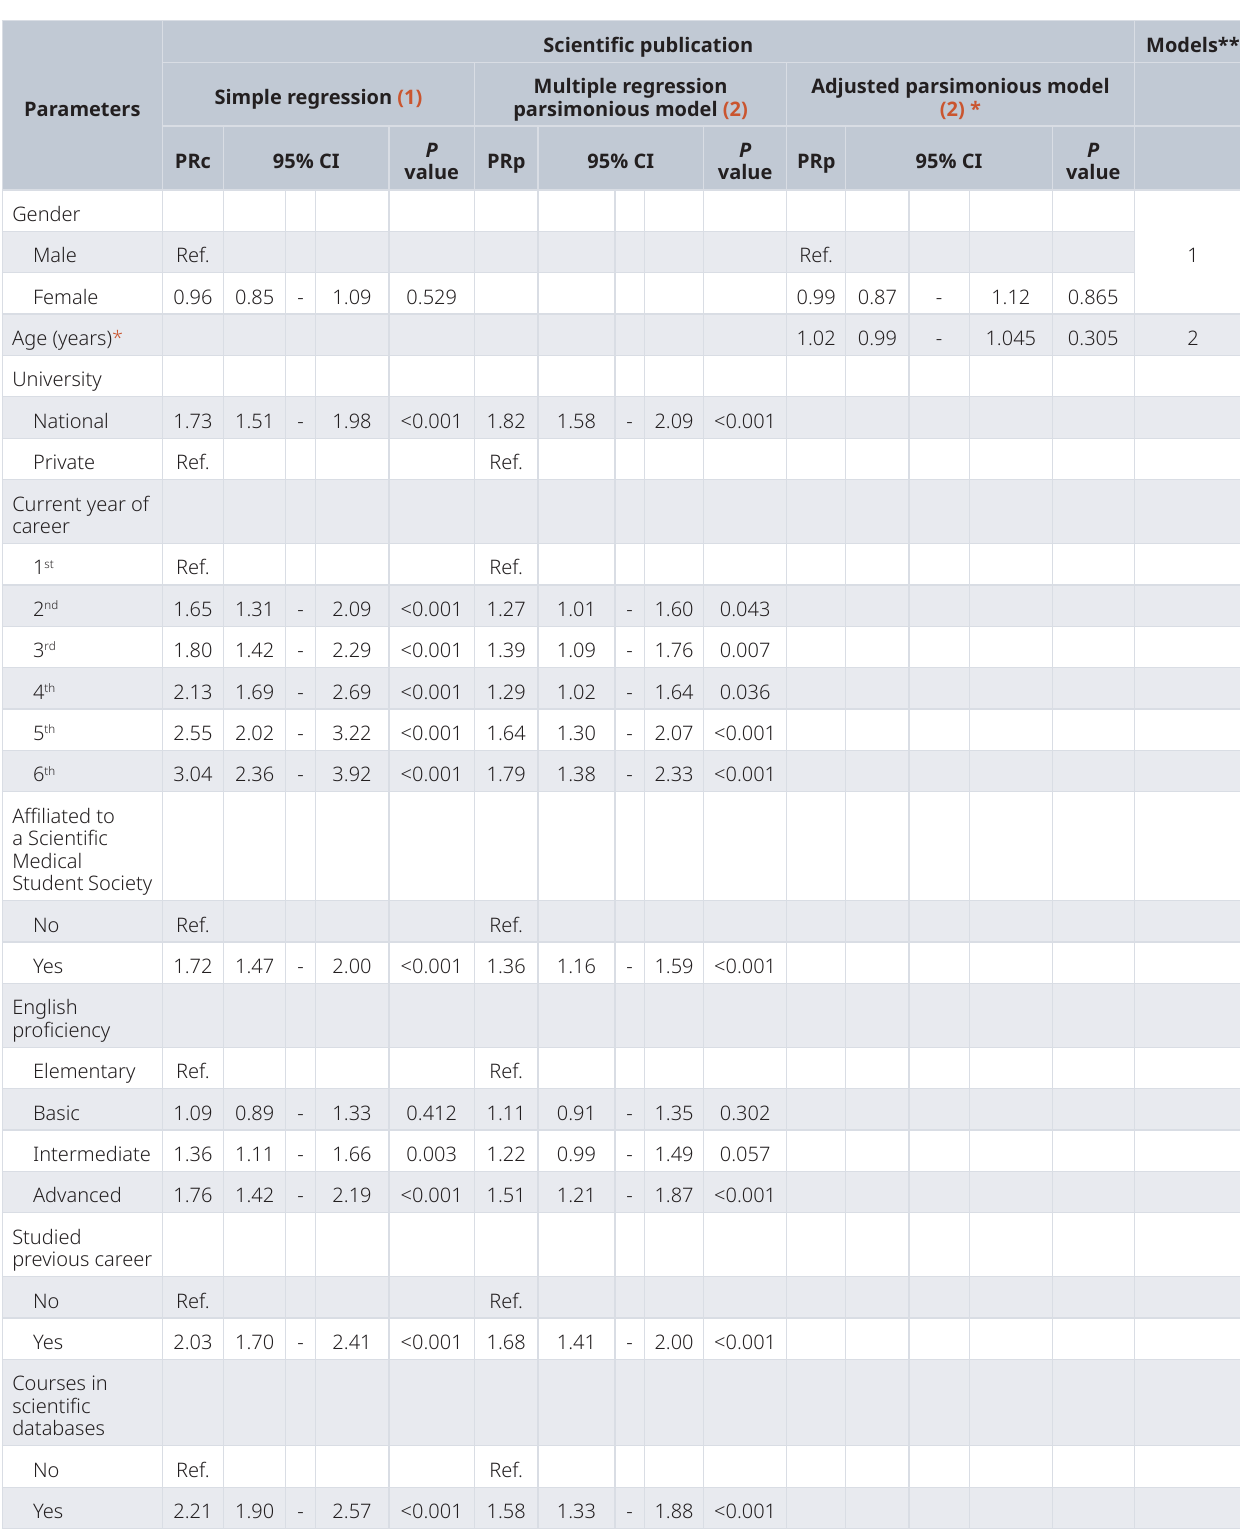
Table 3. Associated factors with scientific publication among medical students from 40 schools of Medicine in Latin America and the